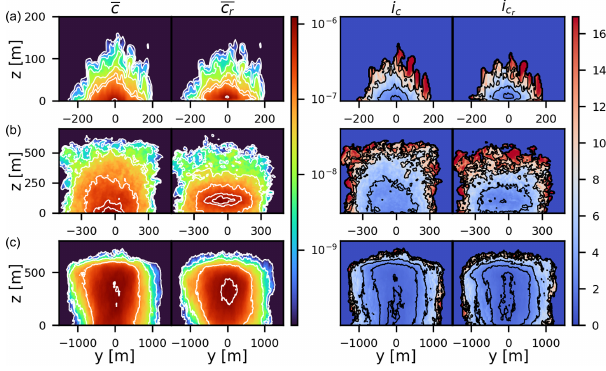
Figure 12. First two columns: y – z transect of mean plume concen- trations in absolute ( c ) and relative ( c r ) coordinate systems. Last two columns: concentration fluctuation intensity in y – z plume in absolute ( i c ) and relative ( i cr ) coordinate systems. Distances from the source are (a) 100, (b) 600 and (c)